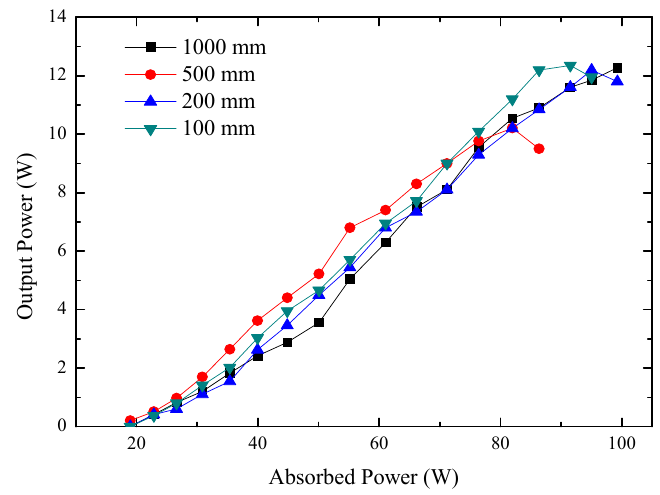
Figure 4. Output power of the Nd:YAG SCF laser with four different OCs; (Curvature radius: 1000, 500, 200 and 100 mm).